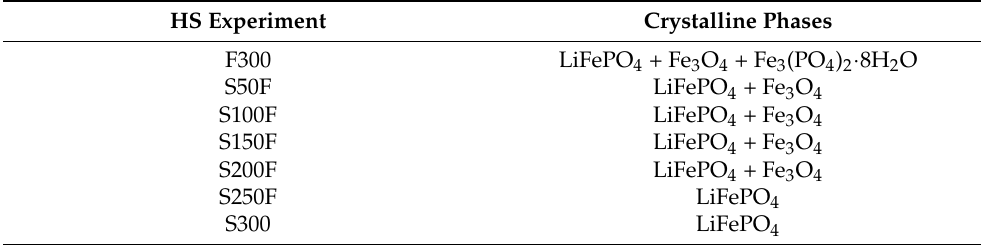
Table 2. Crystalline phases found in the XRD patterns of the synthesized LiFePO 4